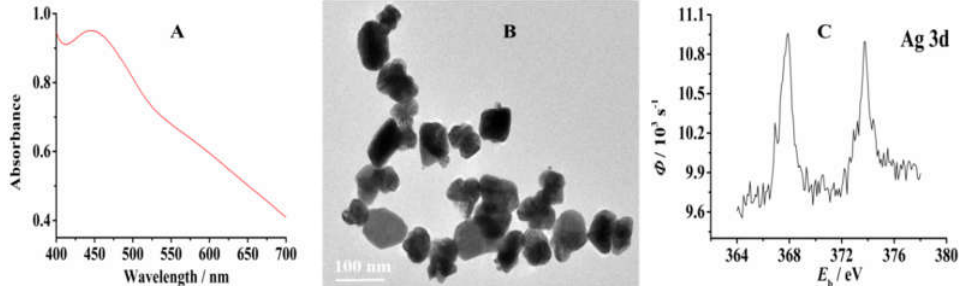
Figure 2. UV–Vis absorbance spectrum ( A ), TEM images ( B ), and XPS spectrum ( C ) of AgNPs synthesized via tea extract.